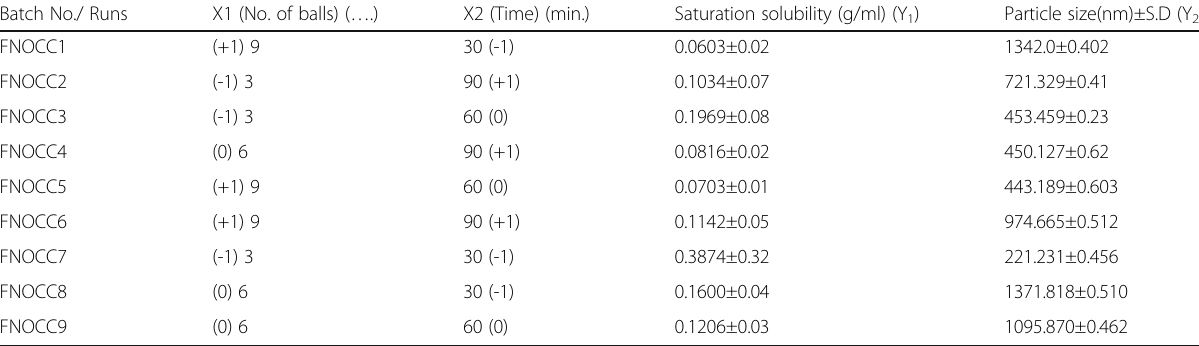
Table 4 Effect of No. of balls & time on Saturation solubility and particle size distribution of co-crystal ( n = 3, mean ± SD) Batch No./ Runs